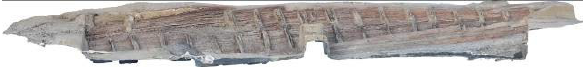
Figure 13. Orthophoto of the prospect of the hull in